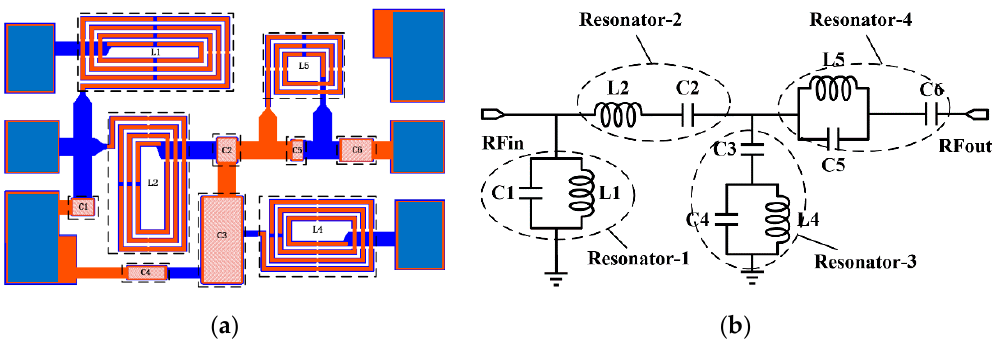
Figure 5. ( a ) 2D topology and ( b ) circuit model of the proposed filter.